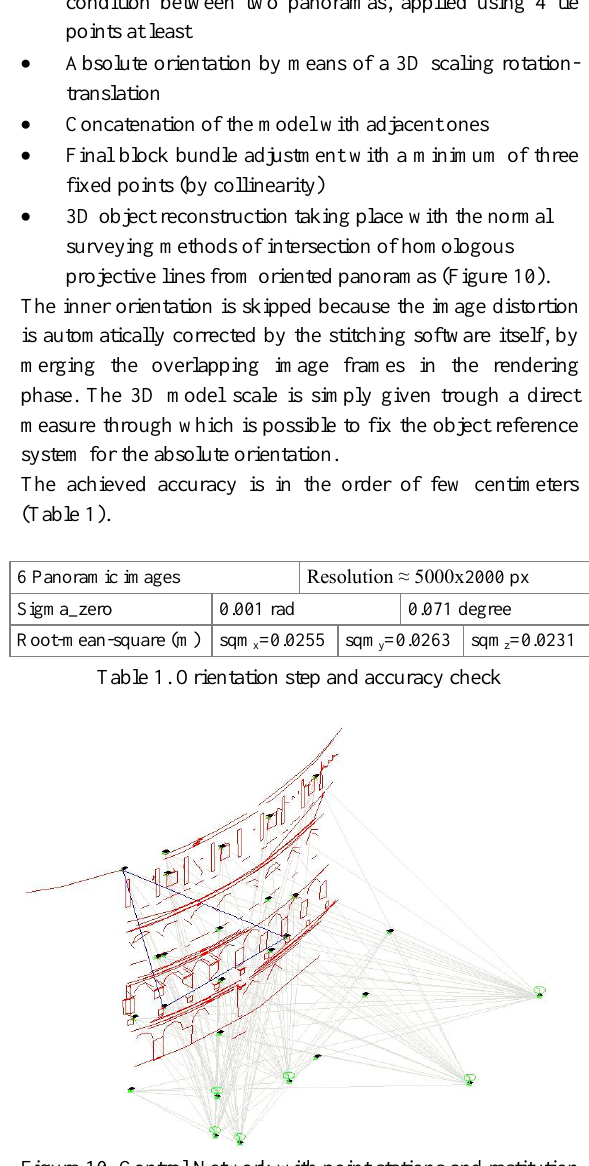
Figure 10. Control Network with point stations and restitution red lines plotted by Spherical